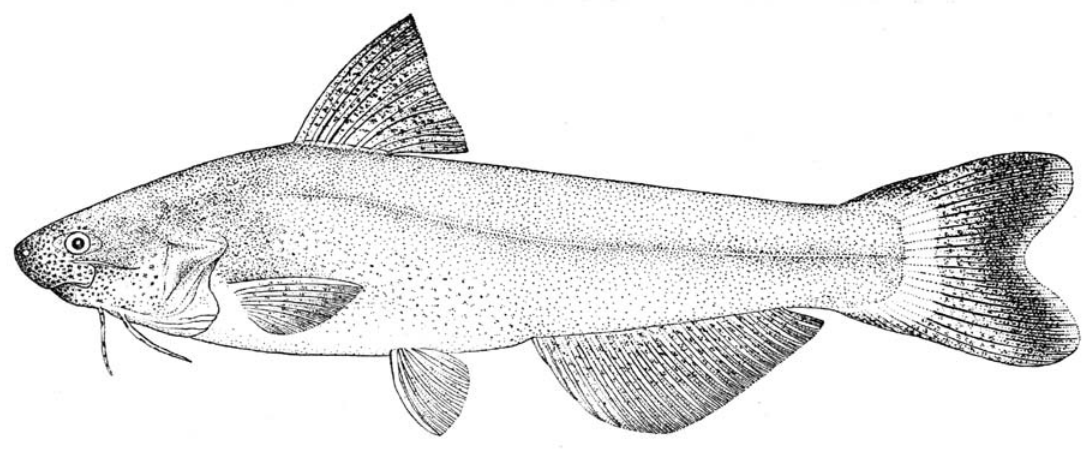
Fig. 24. Cetopsis jurubidae , holotype of Pseudocetopsis jurubidae , ANSP 71430; Colombia, Chocó, río Jurubidá, Nuquí (5°42’N, 77°17’W); as illustrated by Fowler (1944, fig.